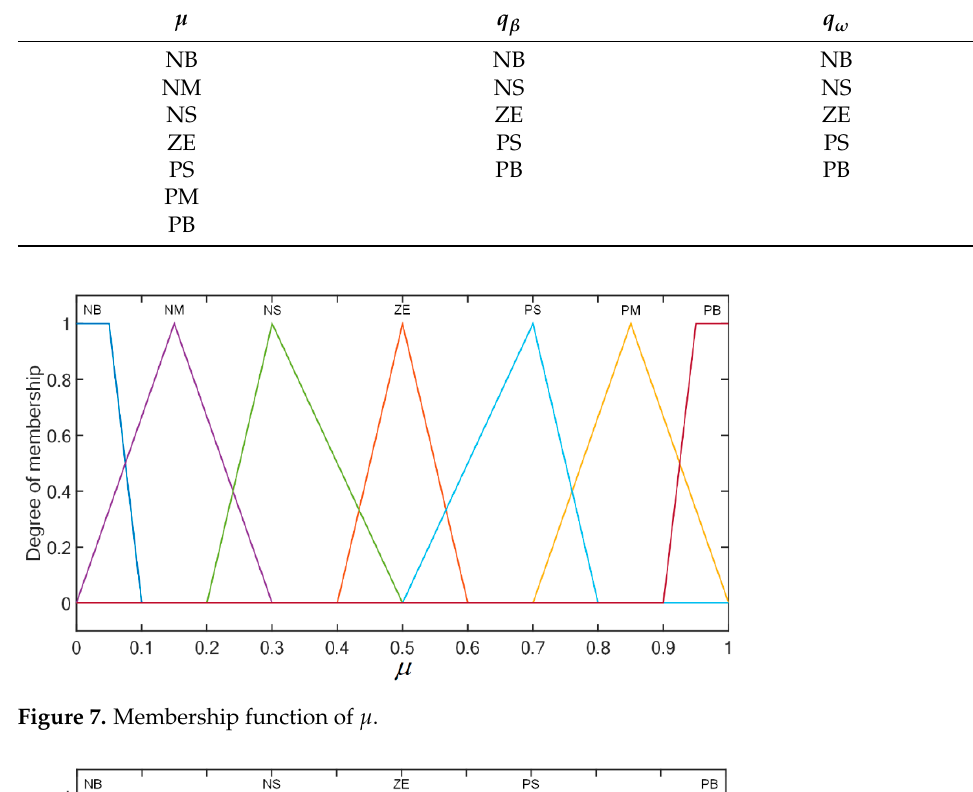
Figure 7. Membership function of μ .